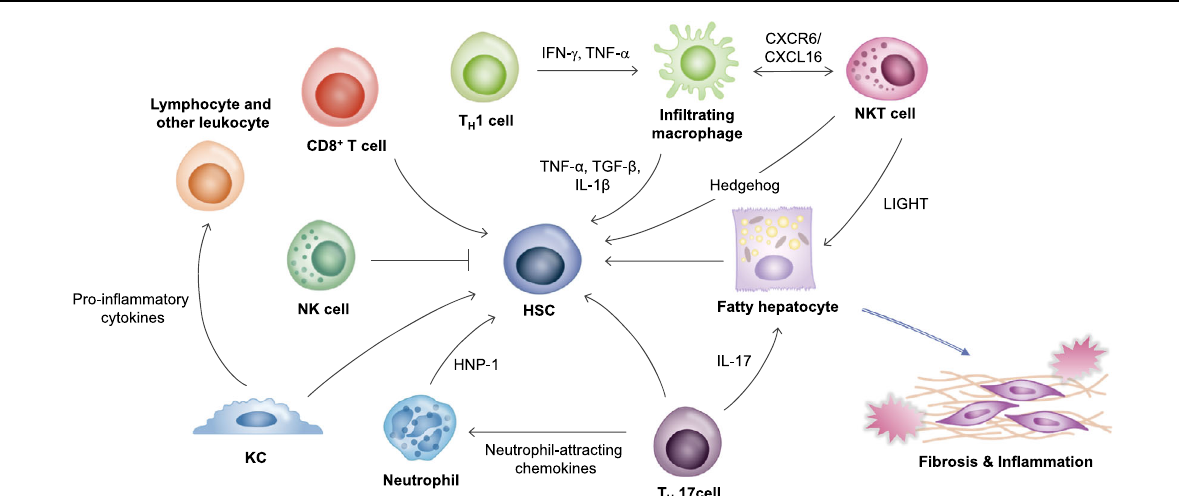
Fig. 1 The immunological microenvironment of nonalcoholic steatohepatitis. The liver has the largest population of resident macrophages (KCs) and high densities of NK cells, NKT cells, various T cells and liver-transiting and/or resident lymphocytes, with a higher ratio of CD8 + T cells to CD4 + T cells than that in the periphery. Liver nonparenchymal cells are associated with innate and adaptive immune systems and control the liver microenvironment. During NASH progression, these cells functionally interact with each other by secreting cytokines and chemokines to induce pro fi brotic and proin fl ammatory signals. Immune cells also interact with other cells in the liver microenvironment, especially hepatic stellate cells (HSCs) and hepatocytes, to promote fi brosis and in fl ammation that can affect disease severity. Th1 cells can affect macrophages by secreting IFN- γ and TNF- α . These macrophages can produce cytokines to activate HSCs. CD8 + cells, Th17 cells, KCs, and neutrophils also contribute to the activation of HSCs. In contrast, NK cells inhibit the activation of HSCs. NKT cells and Th17 cells induce lipid accumulation in hepatocytes. Thus, altered immune regulation in the liver microenvironment can eventually lead to NASH